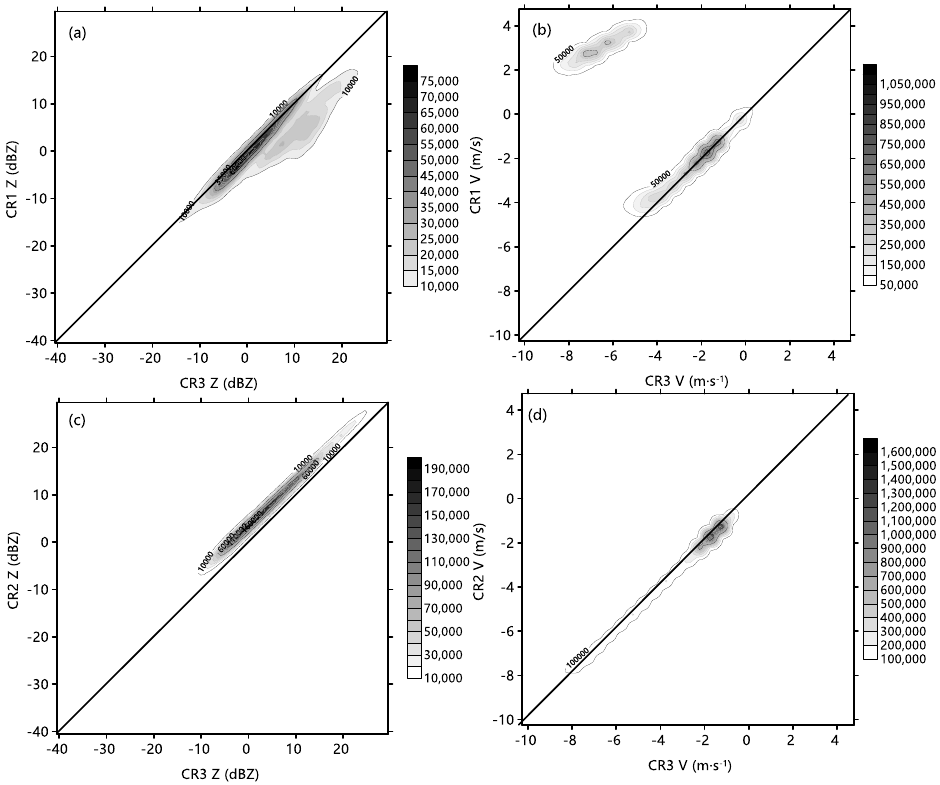
Figure 6. Two-dimensional number-of-occurrences of reflectivity and radial velocity from observations of ( a ) reflectivity for CR3 and CR1 in dBZ; ( b ) radial velocity for CR3 and CR1; ( c ) reflectivity for CR3 and CR2 and ( d ) radial velocity for CR3 and